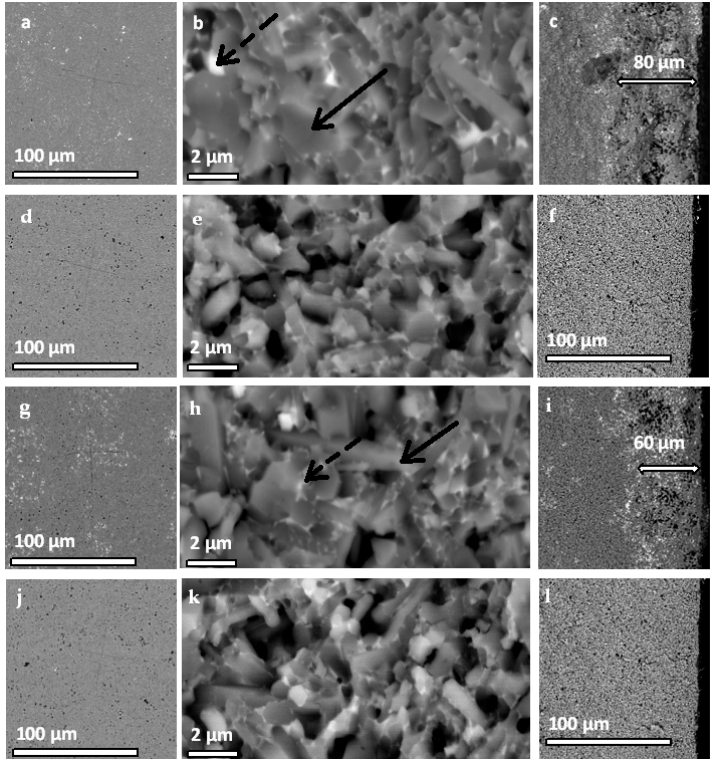
Figure 6. Micrographs of the Si 3 N 4 material sintered pressureless at a temperature of 1800 °C ( a – c ) and in the hot isostatic press at a temperature of 1800 °C ( d – f ); Si 3 N 4 -nSiC material containing 5 wt.% of silicon carbide sintered pressureless at a temperature of 1800 °C ( g – i ) and in the hot isostatic press at a temperature of 1800 °C ( j – l ). In the first column ( a , d , g , j ), the polished surfaces are presented; in the second ( b , e , h , k ), the fracture surfaces of the samples are presented; and in the third column, the fracture surfaces at the edge of the samples are presented ( c , f , i , l ).